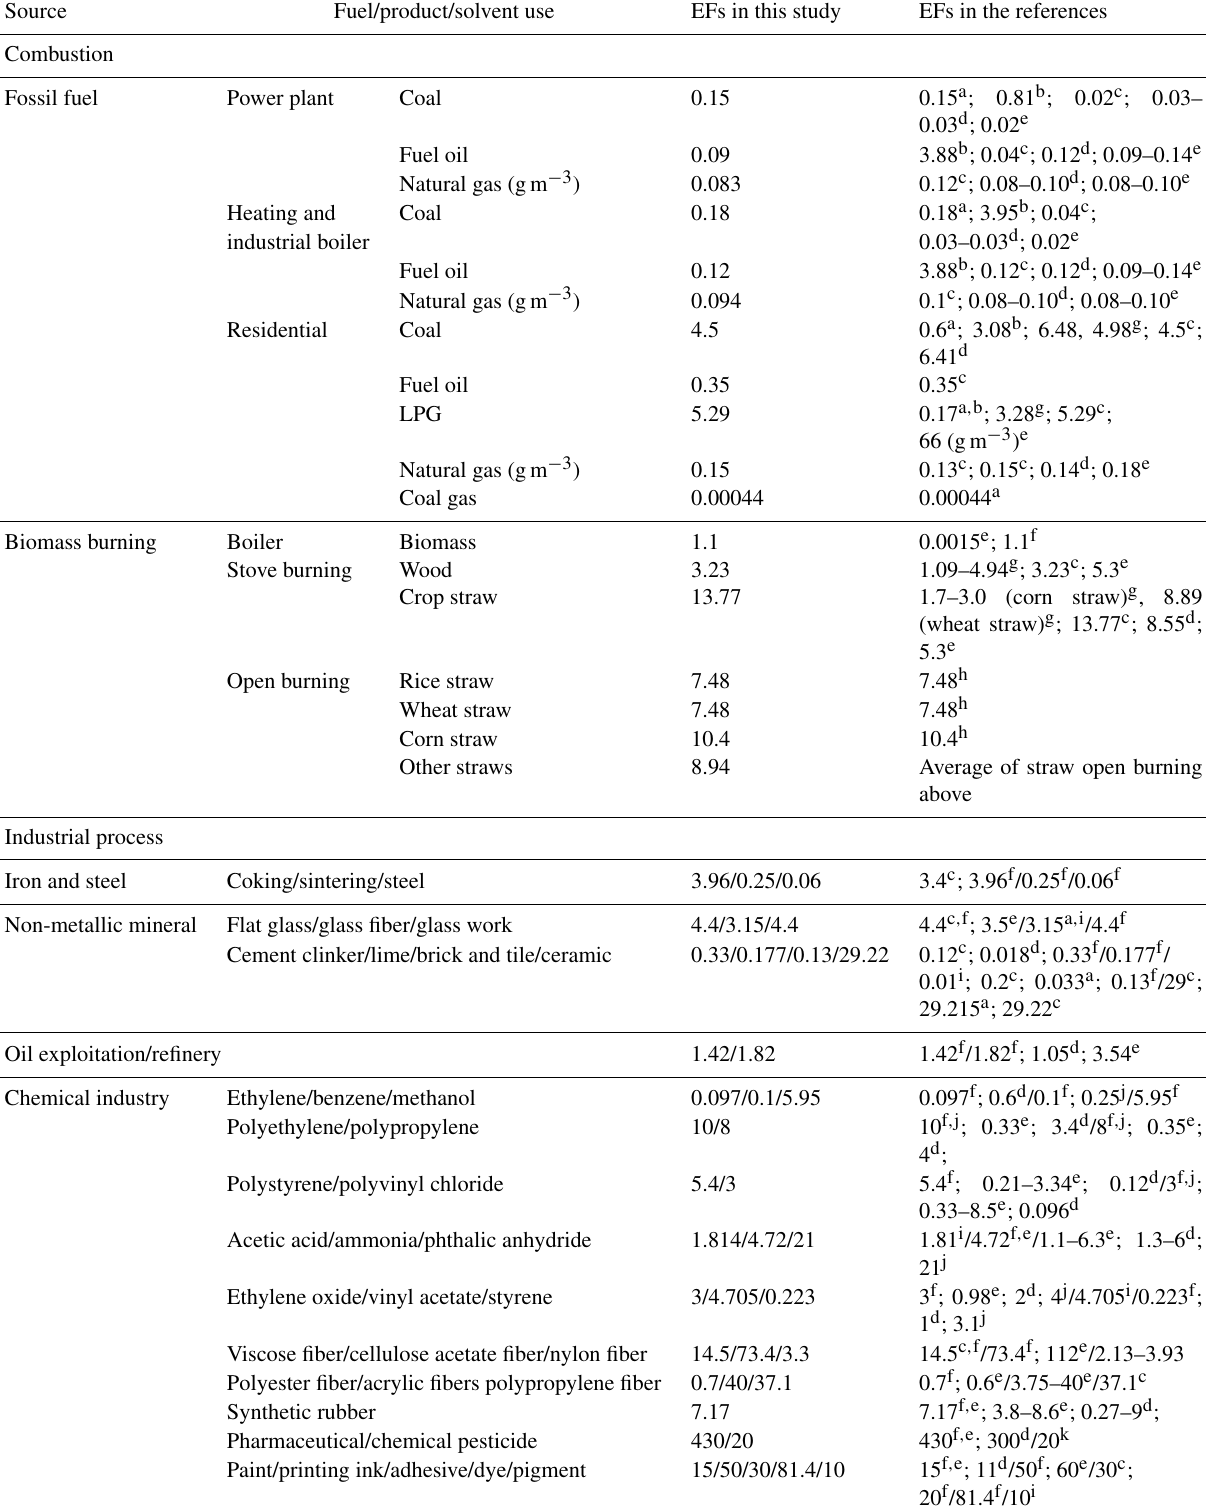
Table 2. NMVOC emission factors for combustion sources, industrial processes and solvent use. Unless specifically noted, the units